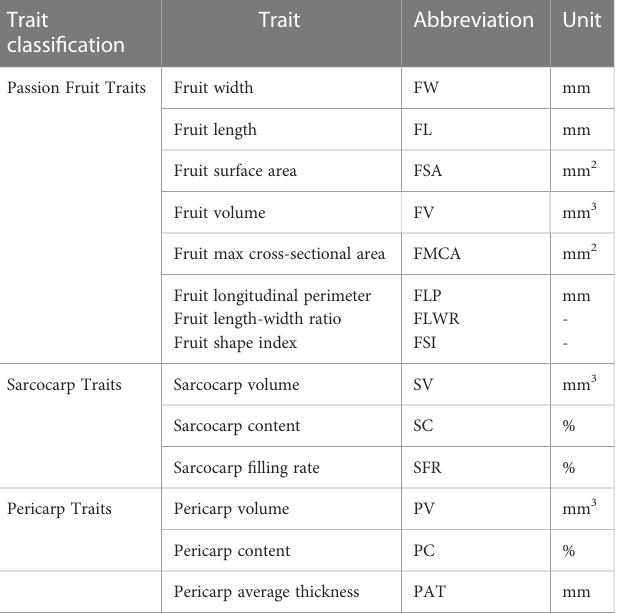
Trait Abbreviation